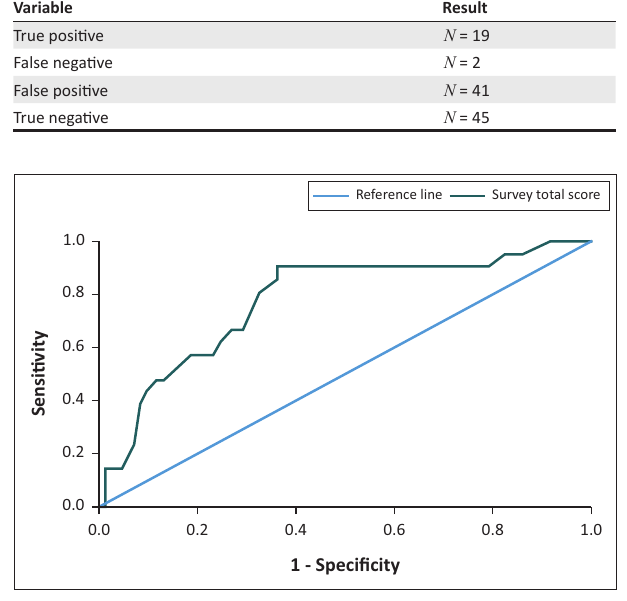
TABLE 6: Basis for deriving sensitivity, specificity, positive and negative predictive values. Variable